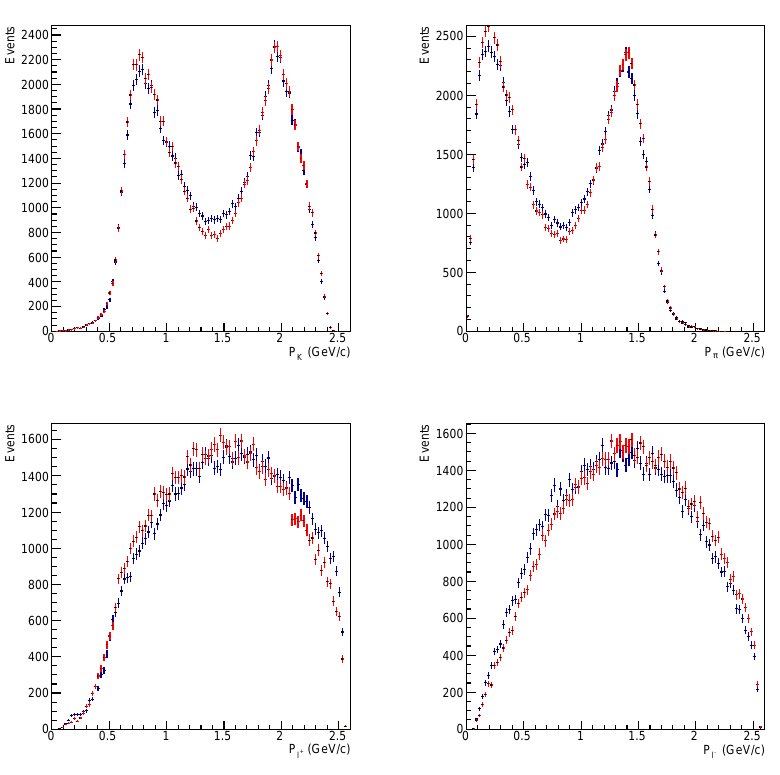
Figure 2. The distributions of momenta of daughter particles for ¯ B 0 → ¯ K ∗ 0 (cid:96) + (cid:96) − , ¯ K ∗ 0 → K − π + decays generated with the “EvtEOSLargeRecoil” model. The SM expectation is shown as red points and a possible new physics case in which C 9 and C 10 are modified by − 0 . 73 and + 0 . 40 is shown as blue